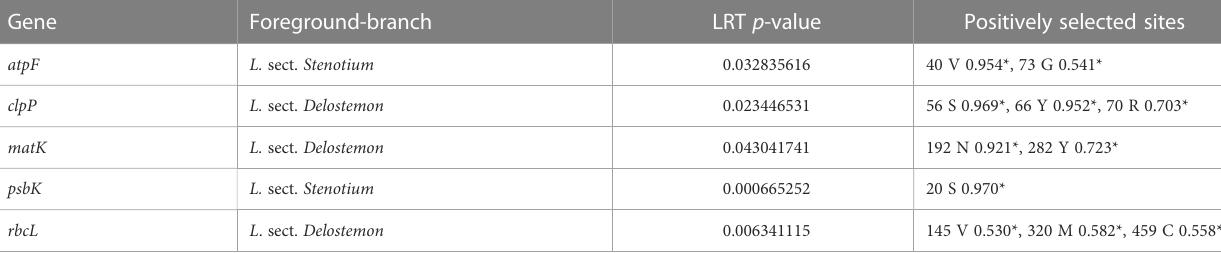
TABLE 2 Genes and sites under positive selection in the plastomes of East Asian lobelias. Gene